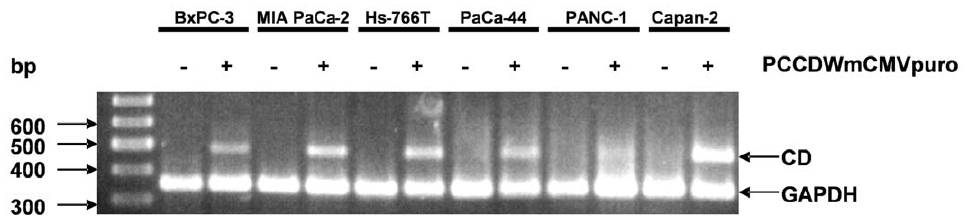
Figure 3. Cytosine deaminase gene expression in PCCDWmCMVpuro-transduced and in parental cell lines. Total cellular RNA was isolated from indicated cell lines and mRNA was reverse transcribed using oligo(dT) primers. CD- as well as GAPH-specific gene fragments were amplified using specific primers and separated on an agarose gel showing the expected sizes of , 480 bp for CD and , 350 bp for GAPDH. The cDNA amount used for PCR amplification was adjusted to yield comparable amounts of the GAPDH gene fragment.